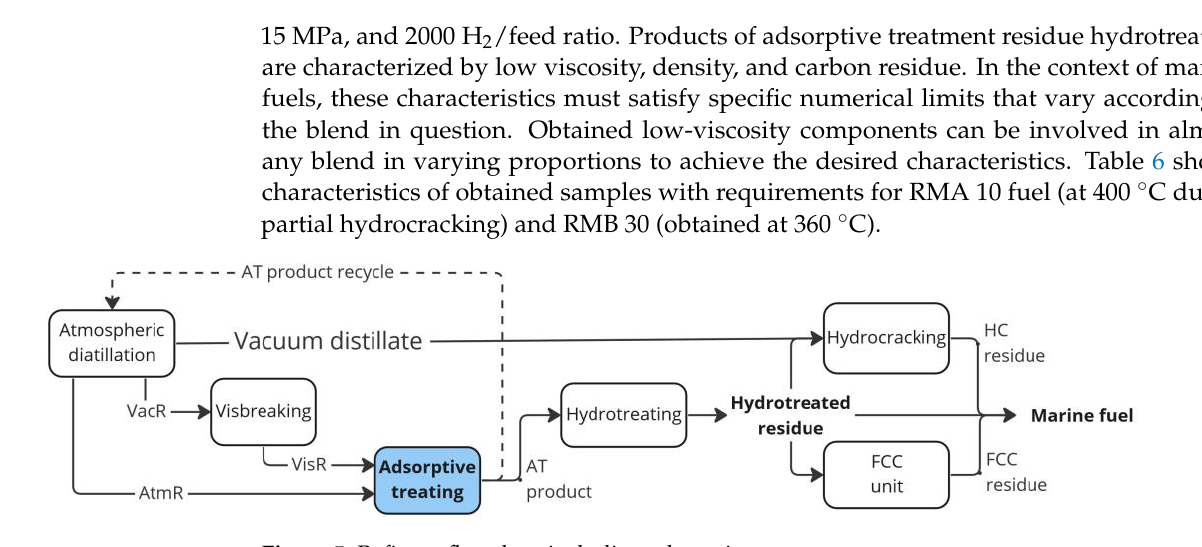
Figure 5. Refinery flowchart including adsorptive treatment. Table 6. Characteristics of hydrotreated atmospheric